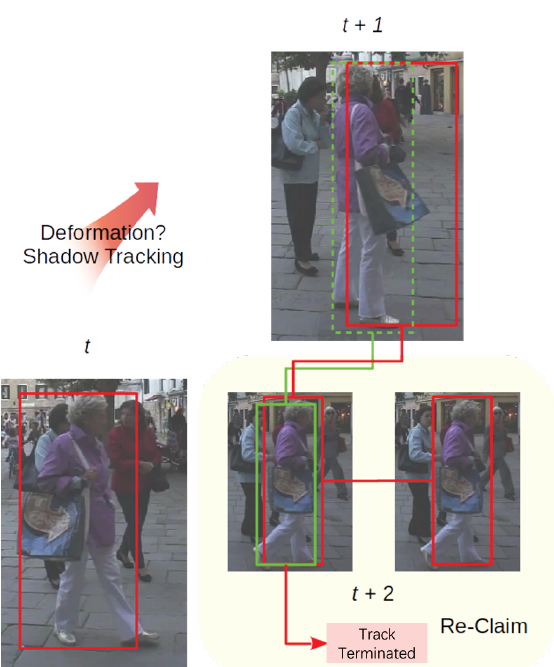
Figure 5. Demonstration of the re-claiming part. When encountering deformation,the single object tracker occasionally keeps on tracking using the trained model with non-deformed appearance features, which then will produce the inaccurate red box at time t + 1. At the same time, the corresponding detection which failed to align with a certain object might lead to the initialization of a new object in the green box. Under this circumstance, the re-claiming part chooses the more accurate bounding box and terminates the newly initiated